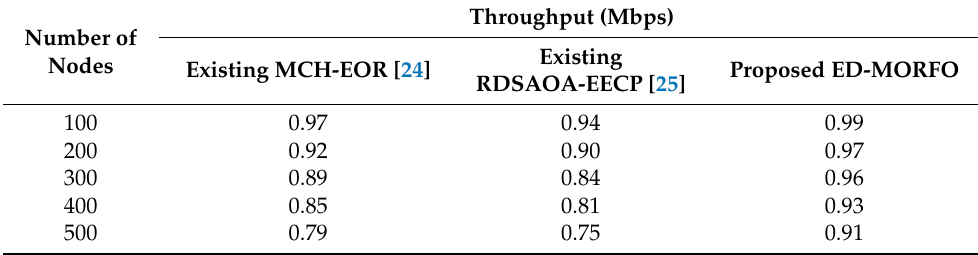
Table 5. Performances of network lifetime.